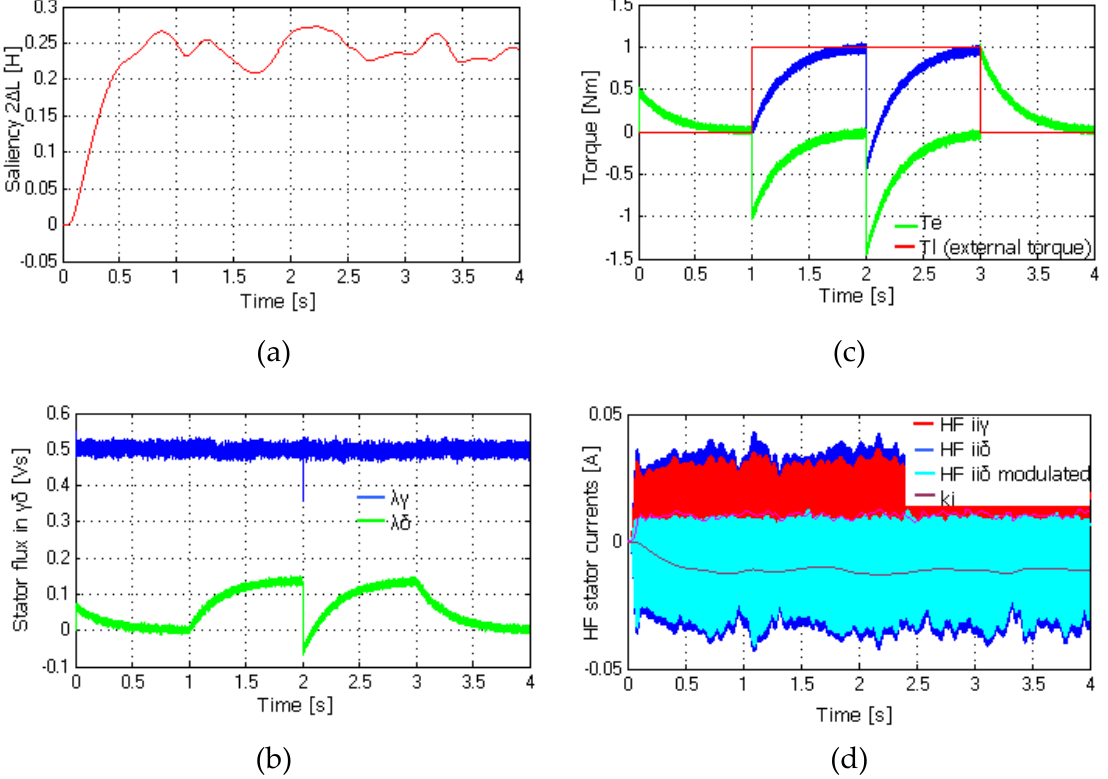
Figure 8. PMSM responses for speed change from 0 rad / s to π rad / s (0.5 Hz) and at t 2 = 2 s from π rad / s to - π rad / s (-0.5 Hz), while an external torque of 1 Nm is applied at t 1 = 1 s and removed at t 3 = 3 s: ( a ) saliency estimation, ( b ) stator flux, ( c ) torque (electrical and load) and ( d ) HF stator currents with estimation of k i parameter. Table 1. Parameters of Permanent Magnet Synchronous Machine (PMSM).